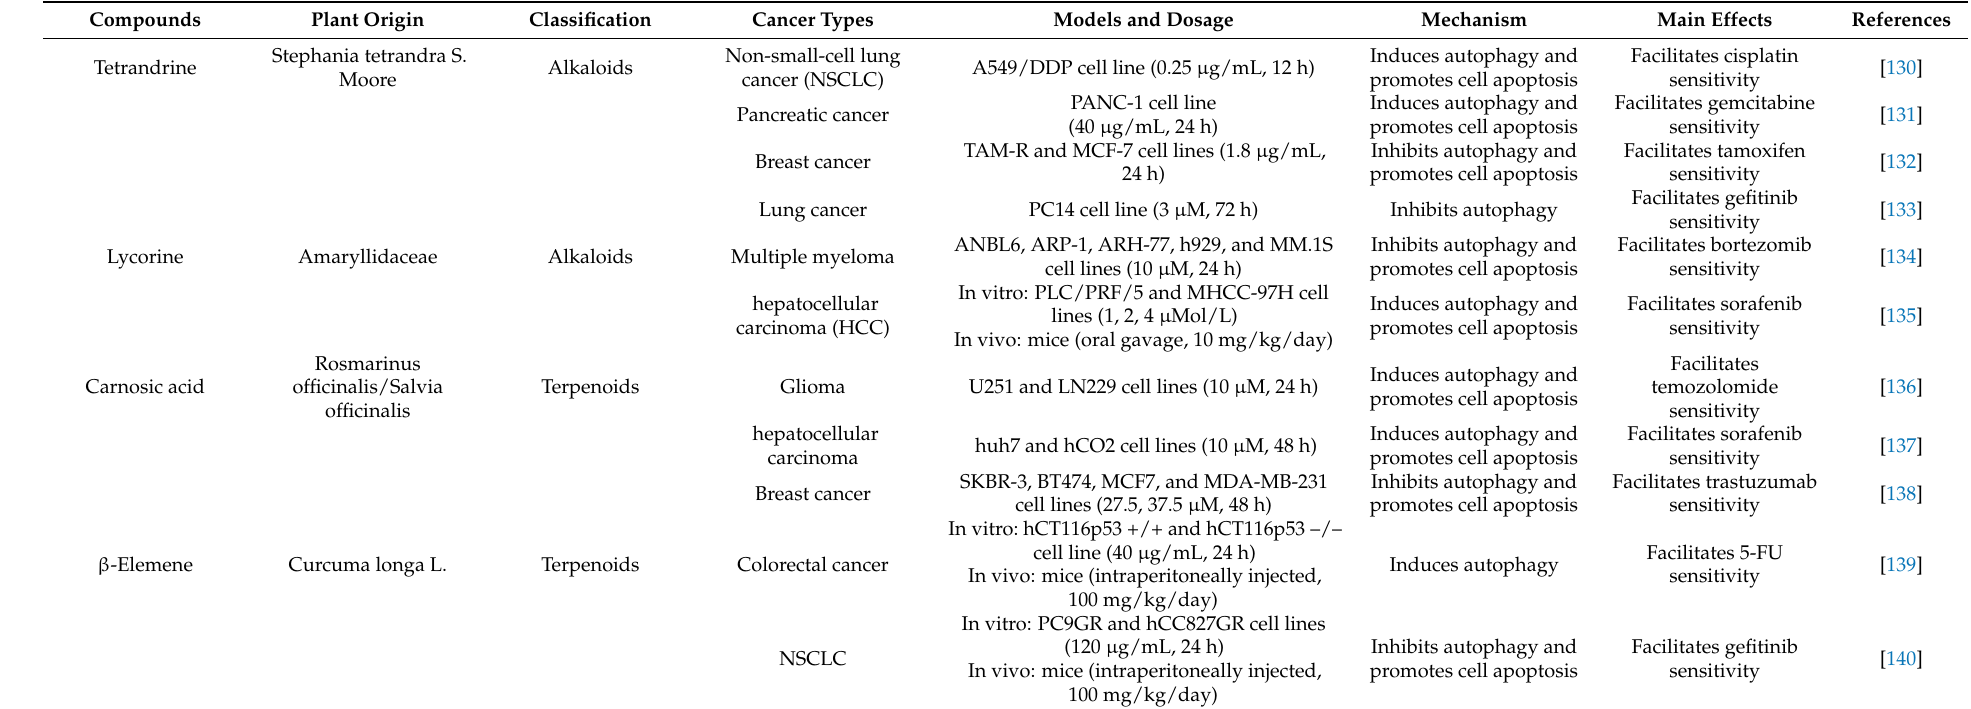
Table 3. Natural products with a dual role in the regulation of